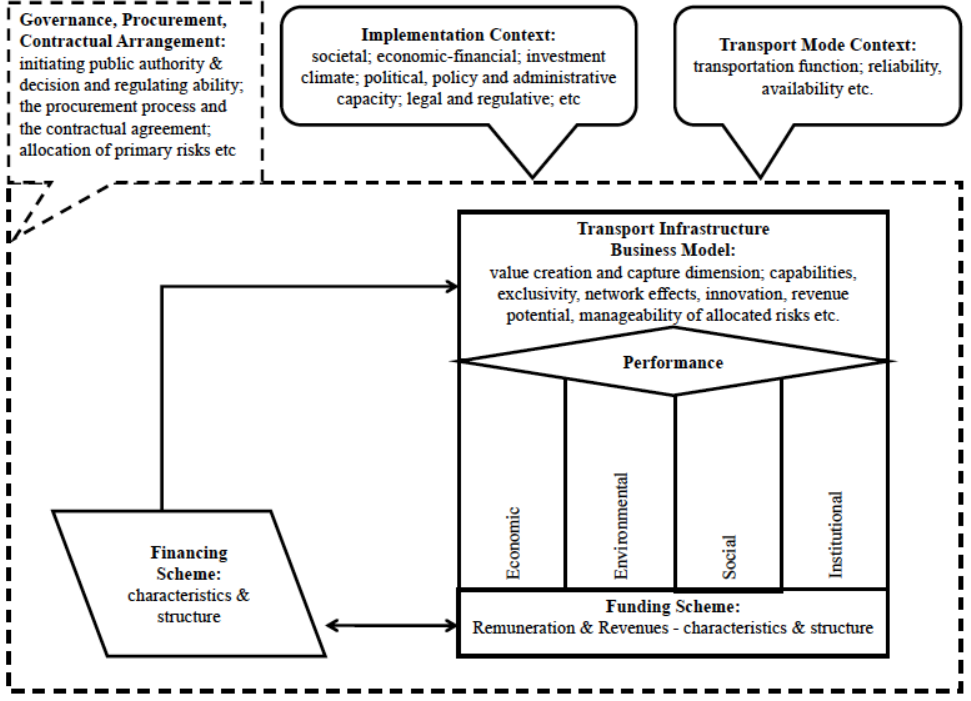
Figure 1. Infrastructure Delivery System and